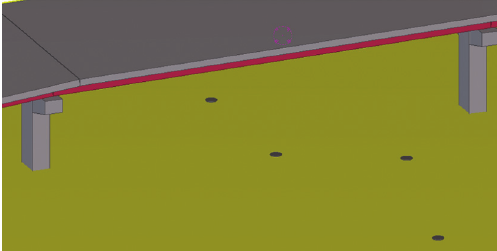
Fig. 7. Exporting GA feasible solutions to Tekla structures